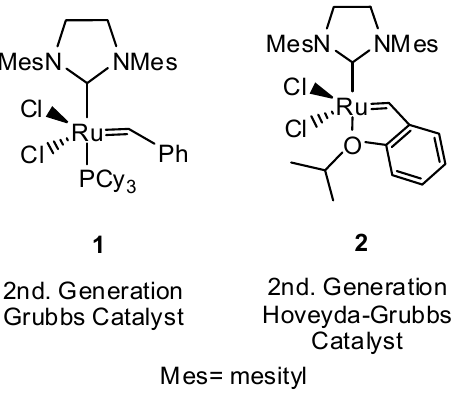
Figure 1. 2nd generation Grubbs and Hoveyda–Grubbs catalysts.